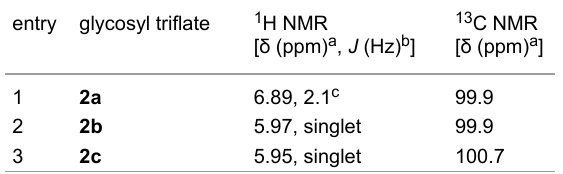
Table 1: 1 H- and 13 C NMR chemical shifts of the anomeric proton and carbon of glycosyl triflates 2a – c